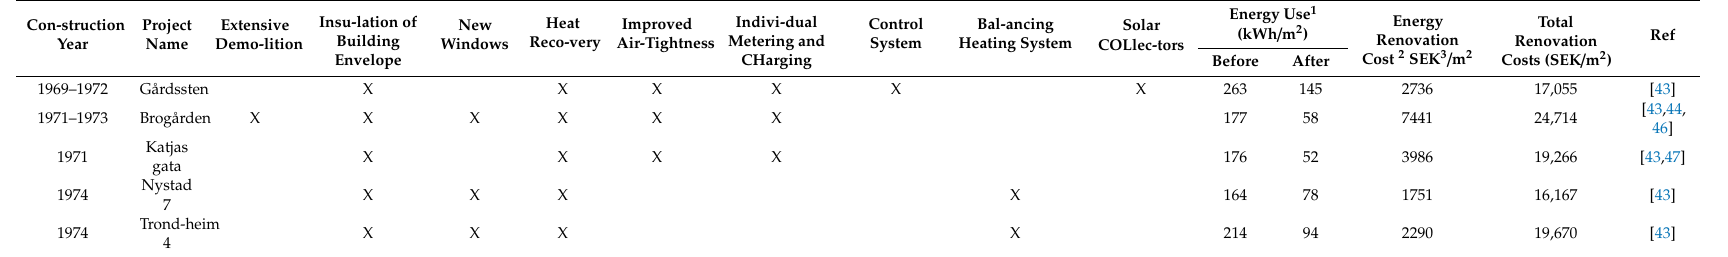
Table 1. Summary of energy renovation performed in